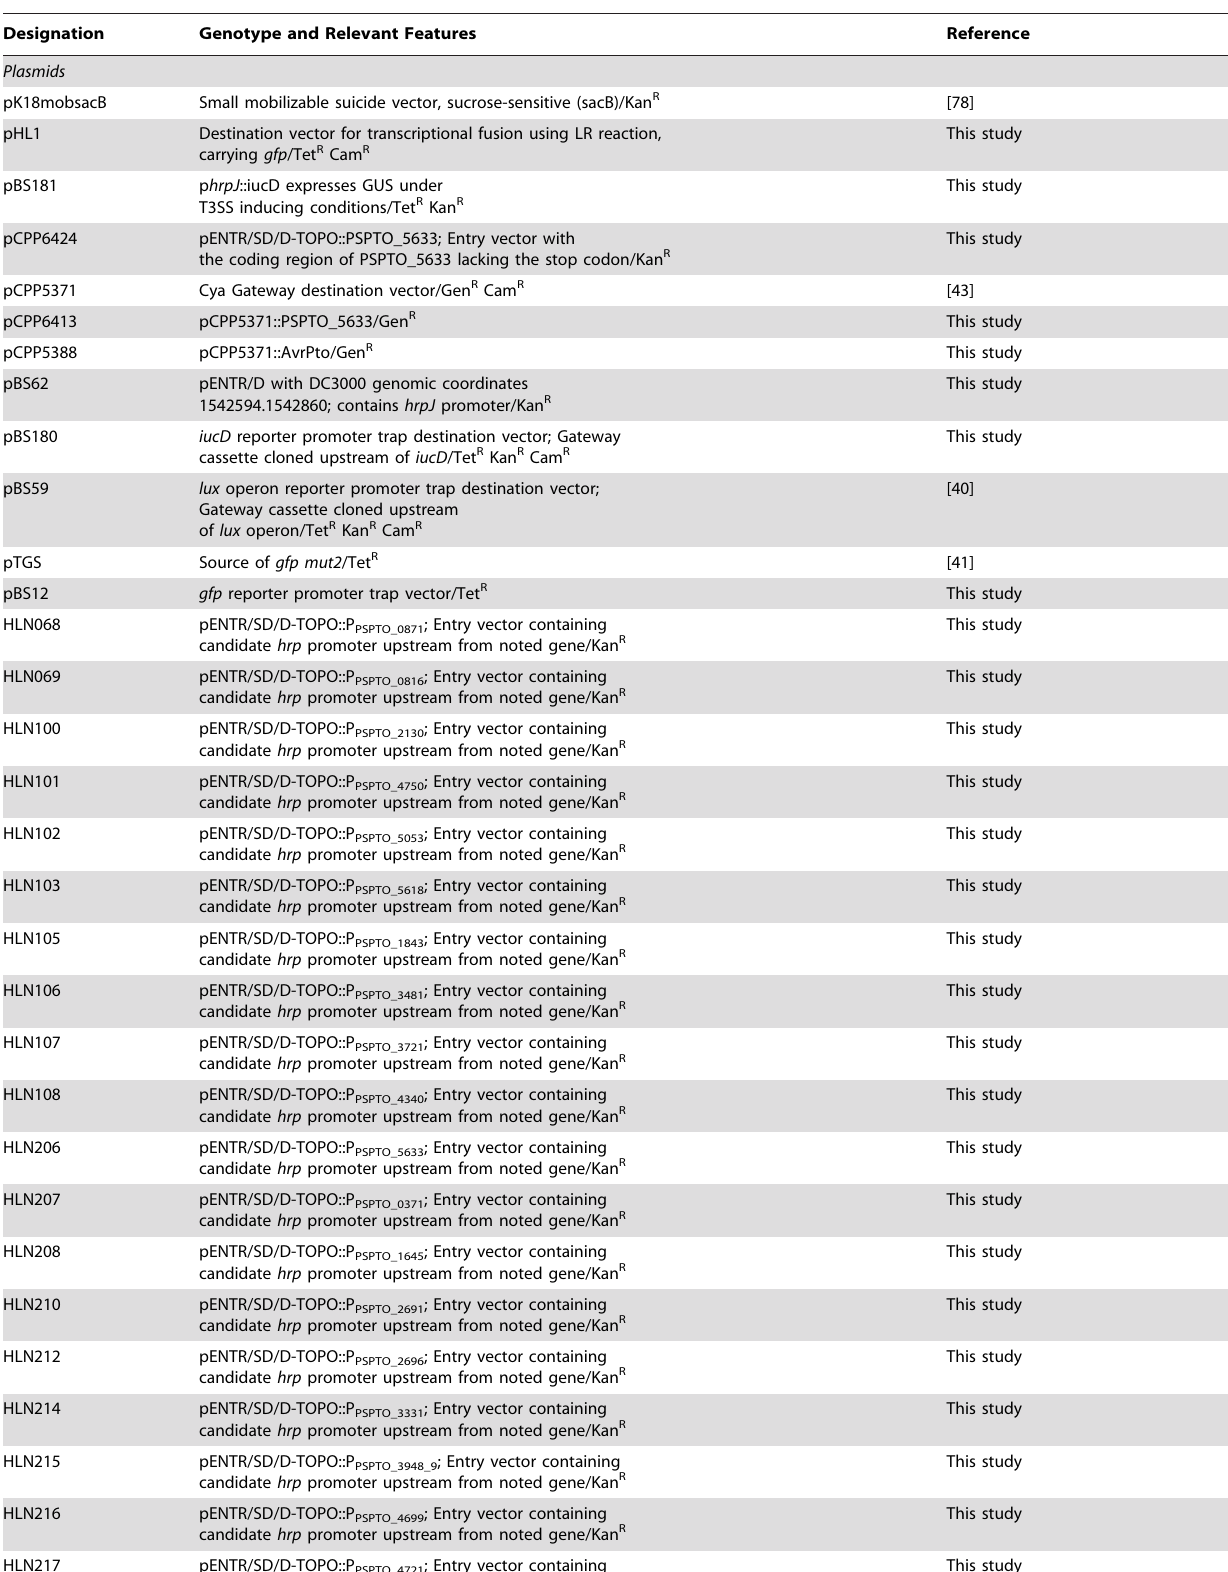
Table 1. All strains used in this